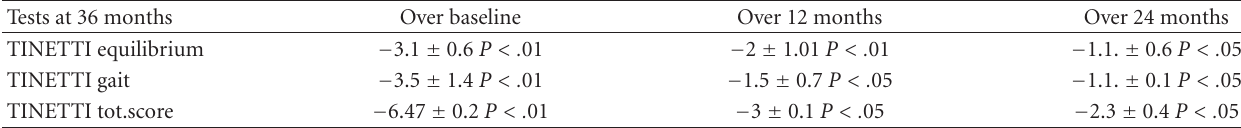
Table 7: Results of gait scores at 36 months: a comparison over 12 and 24